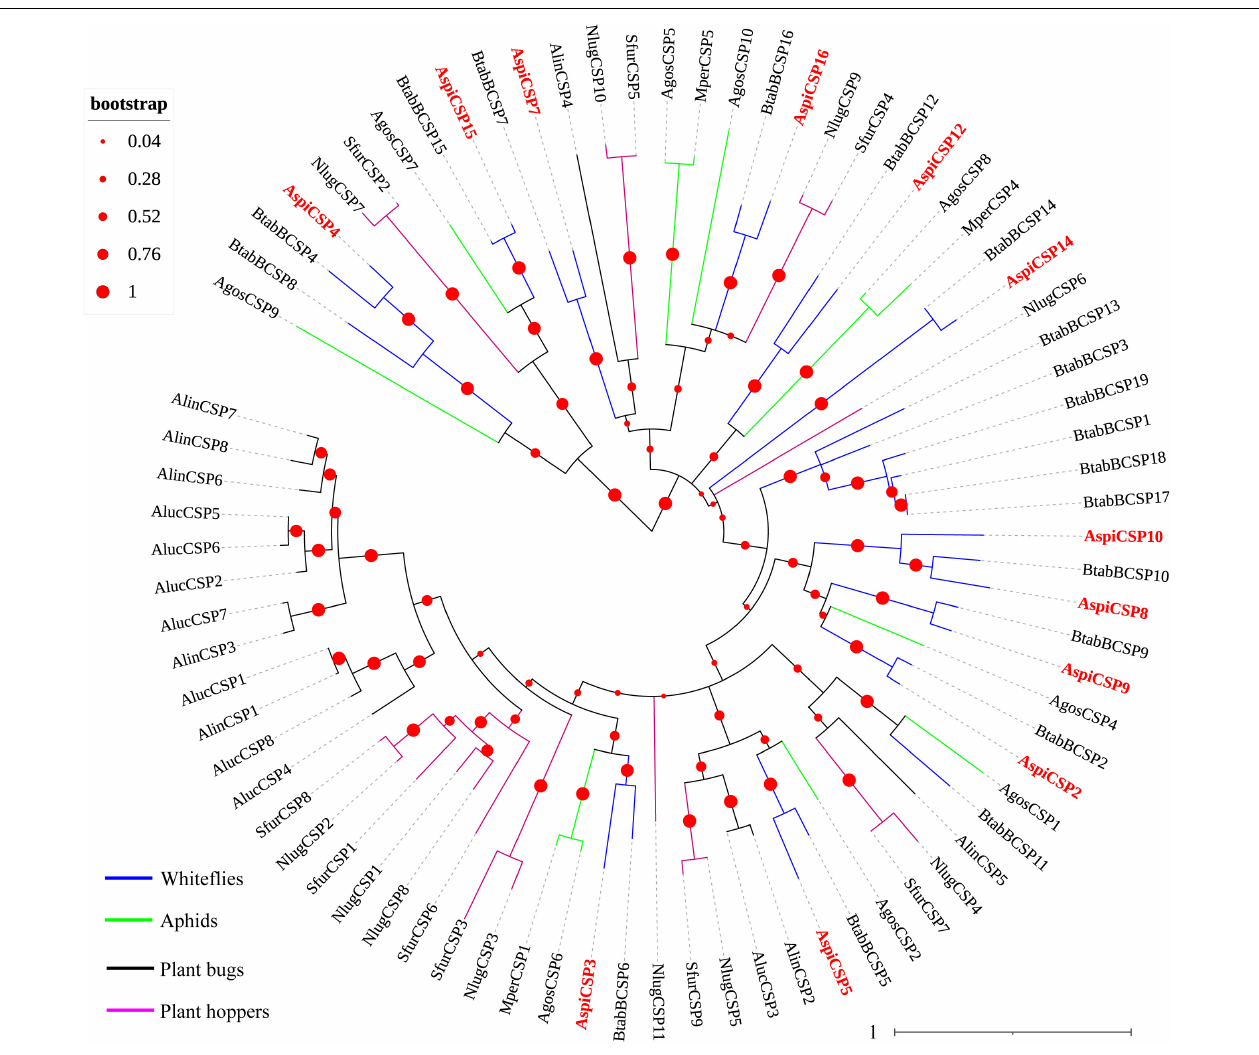
FIGURE 3 | Phylogenetic analysis of putative chemosensory proteins (CSPs) of A. spiniferus . The phylogenetic tree was built using CSP sequences from whitefly species (Btab, B. tabaci ; Aspi, A. spiniferus ), aphid species (Apis, A. pisum ; Agos, A. gossypii ), plant hoppers (Sfur, S. furcifera ; Nlug, N. lugens ) and plant bugs (Aluc, A. lucorum ; Alin, A. lineolatus